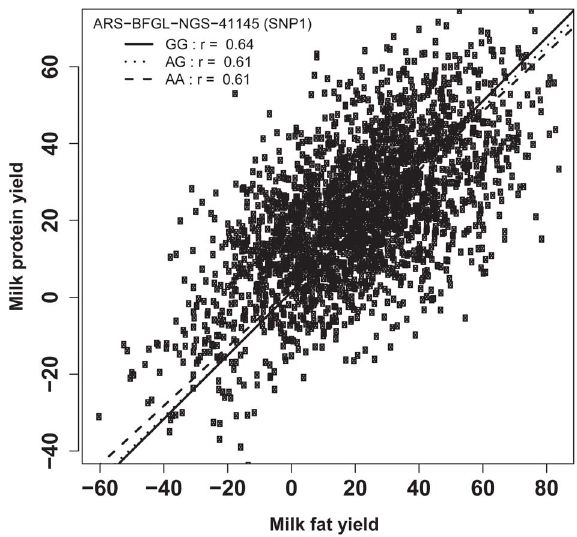
Figure 4. Relationship of milk fat yield to milk protein yield for SNP ARS-BFGL-NGS-41145 (SNP1) in the bull population (Pearson correlation). The solid line is the regression of fat yield on protein yield in the GG genotype class, the dotted line in the AG, and the dashed line in the AA genotype class.